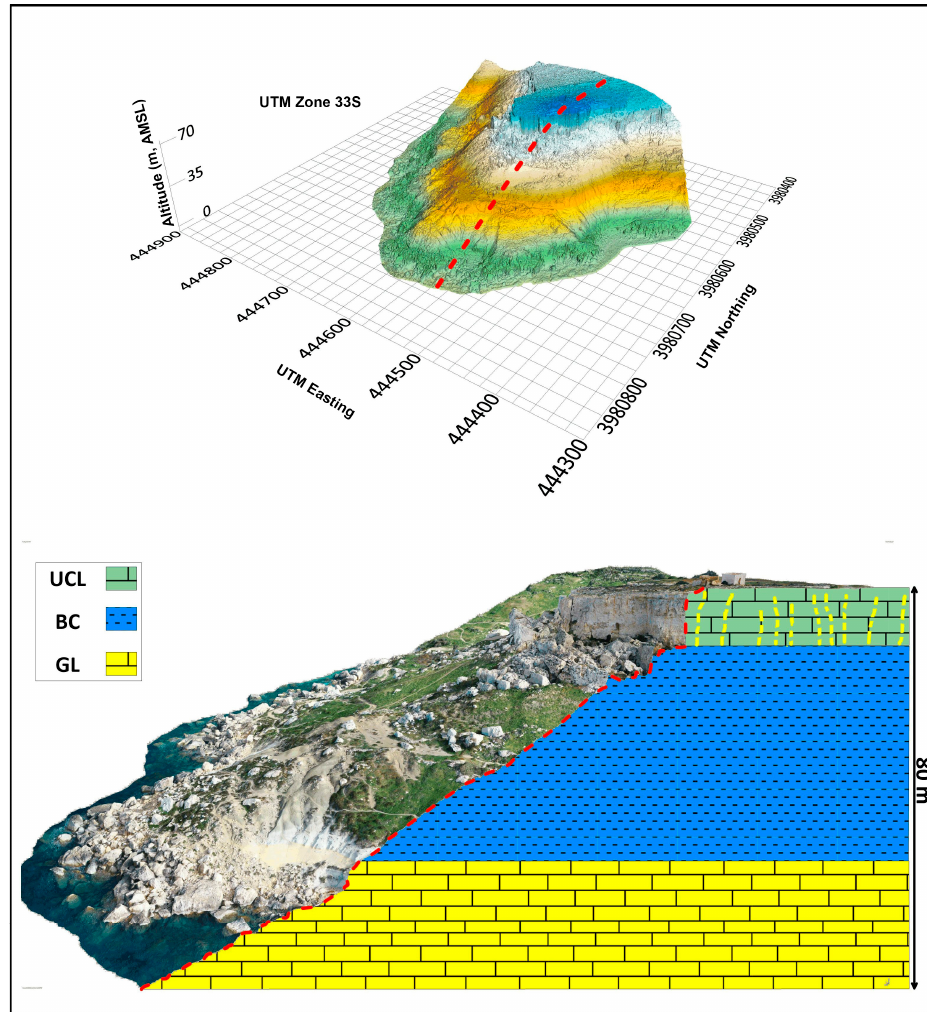
Figure 11. At the top, there is a three-dimensional view of the DEM of the Selmun promontory (Malta) with the red-dotted line indicating the line followed to section the 3D model (uncertainties evaluated by [1]). Below, in the sectioned profile of the three-dimensional model, the sketch of the local geology reconstructed from the geophysical surveys of ERT and GPR was inserted. The yellow dashed lines on the UCL layer are a sketch (not to scale) of the anomalies detected with the two geophysical techniques.